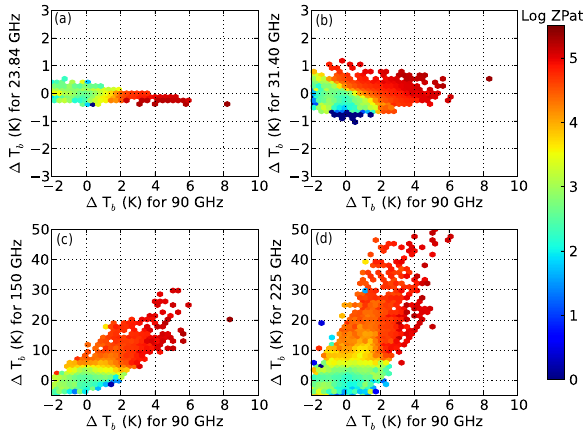
Figure 6. Multi-frequency plots of the BT difference in channels 23.84, 31.40, 150, and 225GHz as compared to the 90GHz chan- nel. The binned values of BT difference are colored according to logarithm of the average Z PATH values. In the top two panels, the lower-frequency channels are plotted against 90GHz (a, b) and in the bottom two panels, the 150 and 225GHz are plotted against the 90GHz (c, d) .